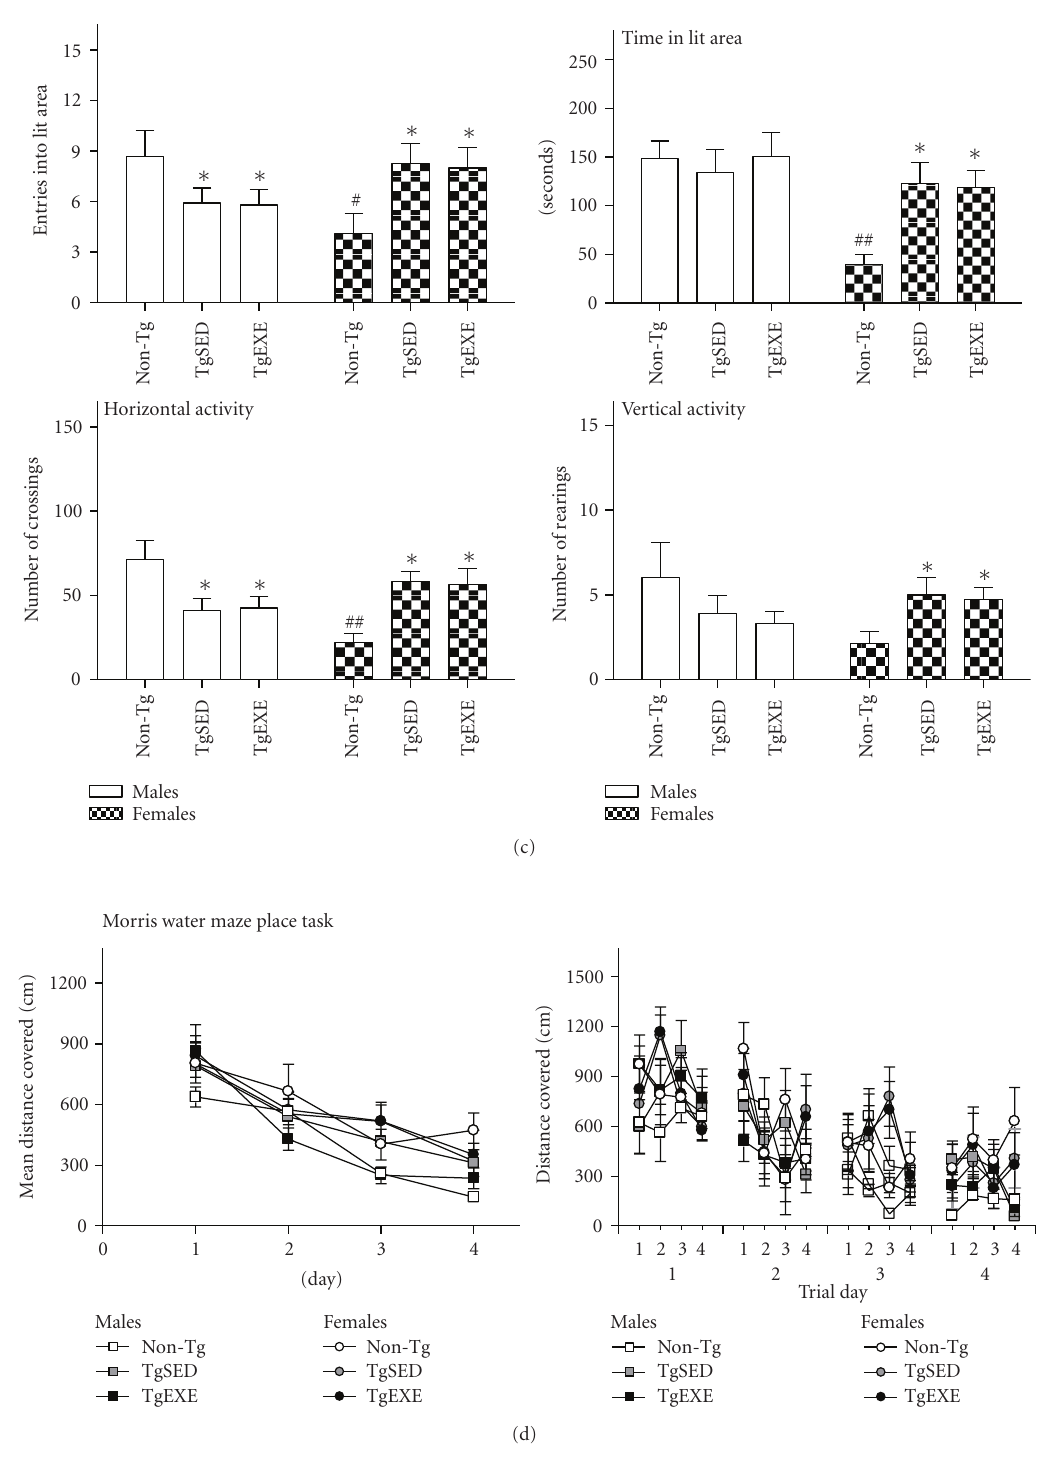
Figure 1: All the behavioral tests do consistently refer to presence of BPSD-like symptoms as a characteristic of early stages of the disease in 3xTg-AD mice, with an important gender component. The e ff ects of exercise are gender dependent. (a) The neophobia in the corner test was increased in both male and female 3xTg-AD mice. (b and c) The anxious profile could be also observed in several variables measured by the open-field test and dark-light box. (d) In the Morris water maze, changes in the swim speed and motivation could be recorded and were mainly important in females (see complementary data in Tables 1(a) and 1(b)). Values are the mean ± SEM, n = 8–10. Statistics: ∗ P < . 05, ∗∗ P < . 01, and ∗∗∗ P < . 001 compared to the corresponding non-Tg; # P < . 05, ## P < . 01 compared to the corresponding